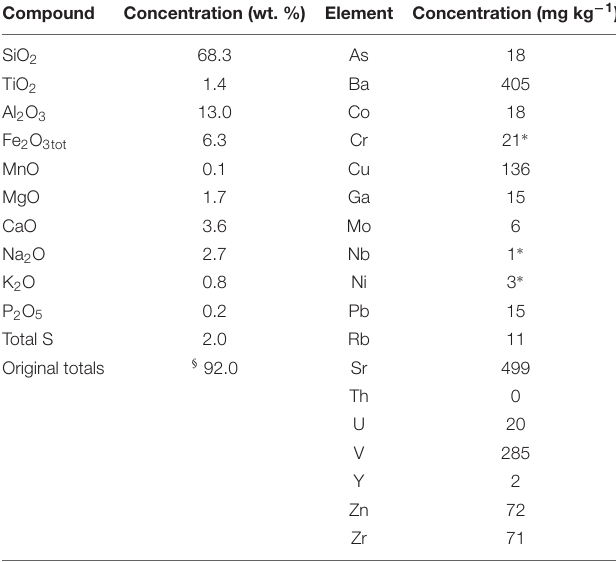
TABLE 2 | Chemical analyses of tephra (volcanic ash sediment) from Haungaroa (035 ROV 15M).